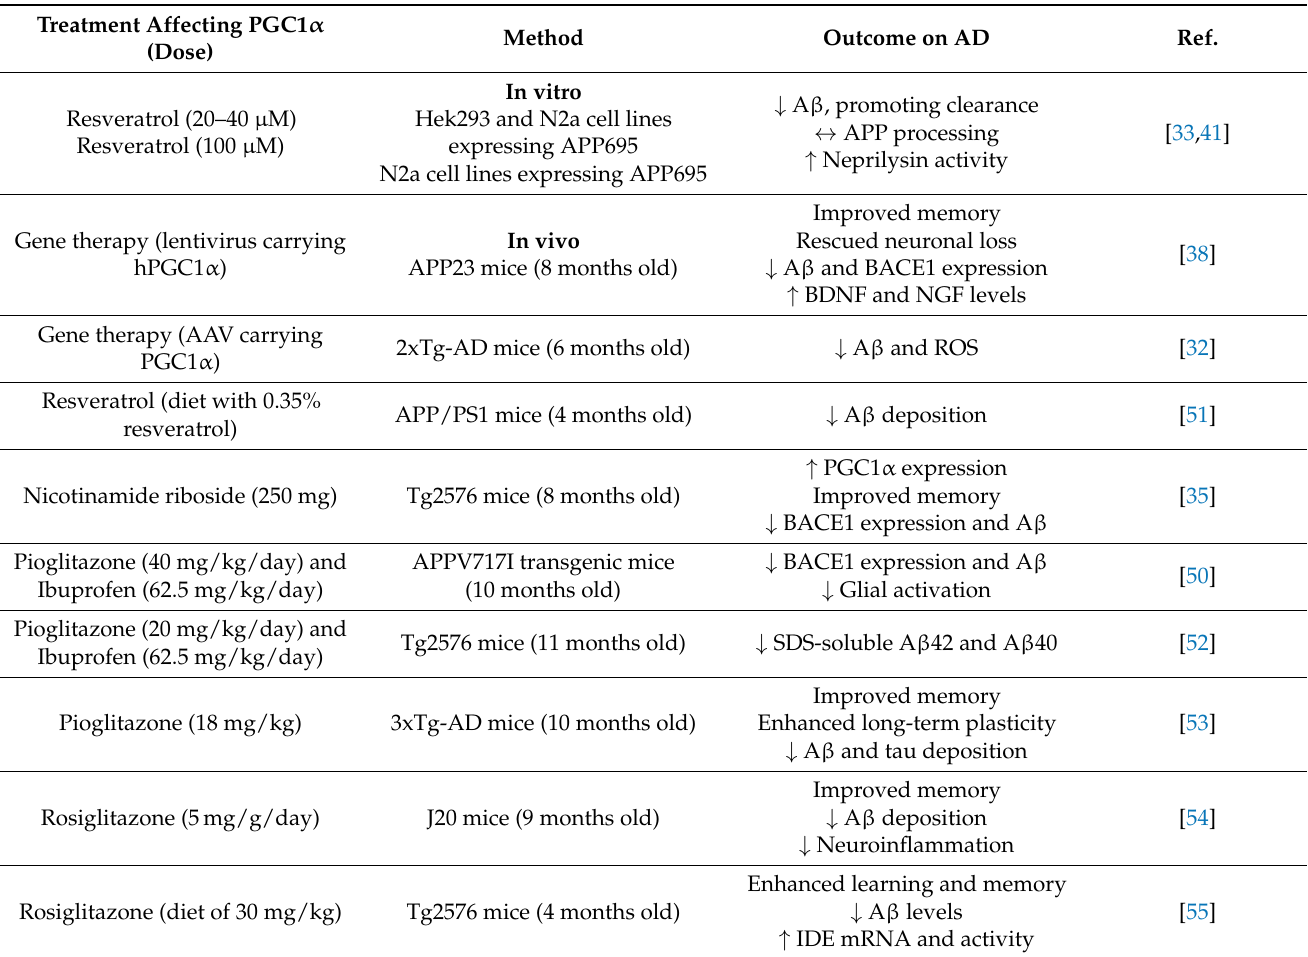
Table 1. Treatments targeting PGC1 α in Alzheimer’s Disease in vitro and in